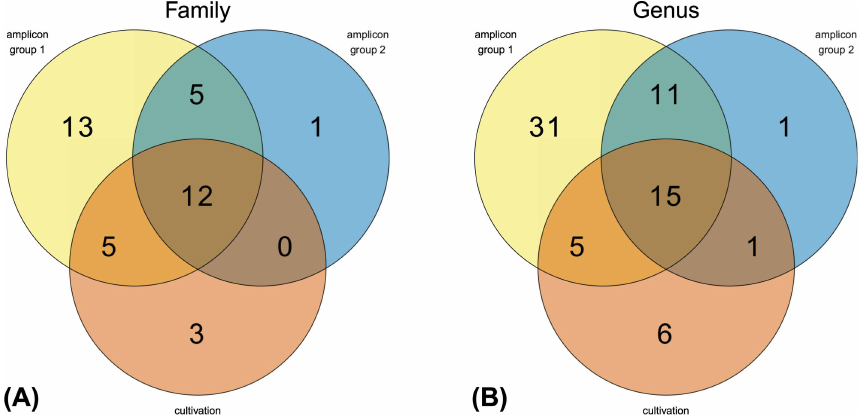
Figure 7. Venn diagram showing shared ( A ) families and ( B ) genera identified in the amplicon data (group 1, group 2) and cultivation-dependent approach (Sanger sequencing). Only one representative per group and ( A ) family or ( B ) genus was counted. Undefined taxa were